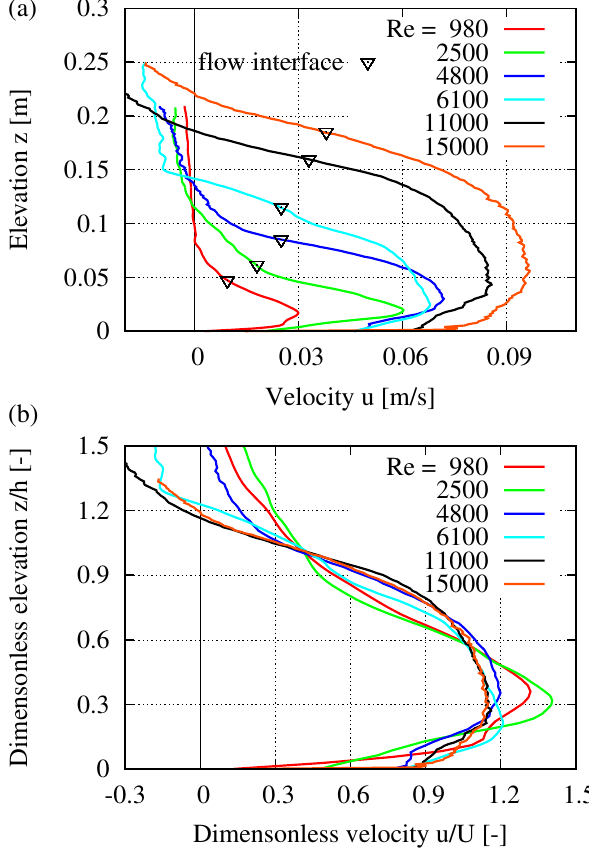
Figure 11. Dimensional (a) and dimensionless (b) averaged veloc- ity profiles: e ff ects of the variation of the flow rate q ; saline currents with ∆ ρ/ρ = 0 . 3% measured in cross section C5 (experiments S5, S6, S7, S17, S9 and S8). The black triangles indicate the flow inter- face level of each current.